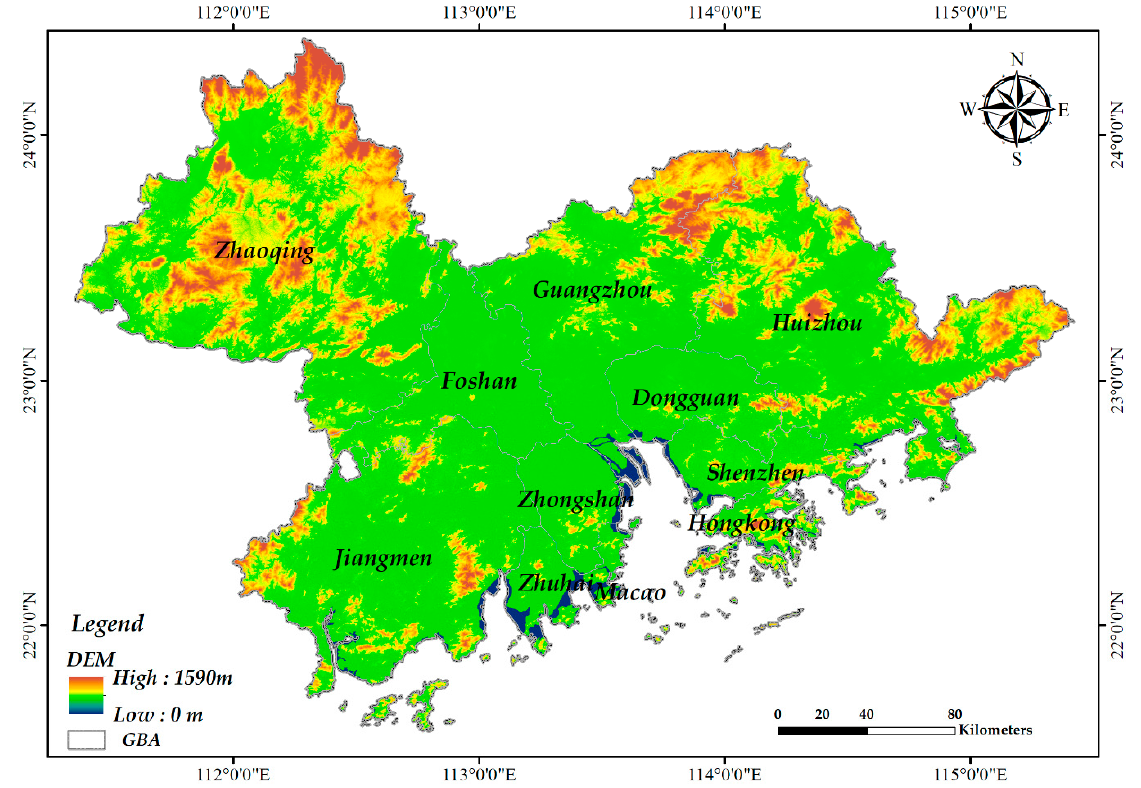
Figure 1. Map of study area. The elevation data are provided by International Scientific and Technical Data Mirror Site, Computer Network Information Center, Chinese Academy of Sciences.